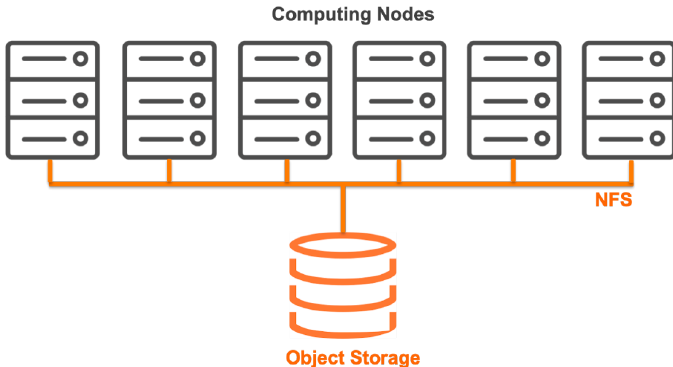
Figure 11. Processing architecture implemented within the ONDA DIAS CC Platform.